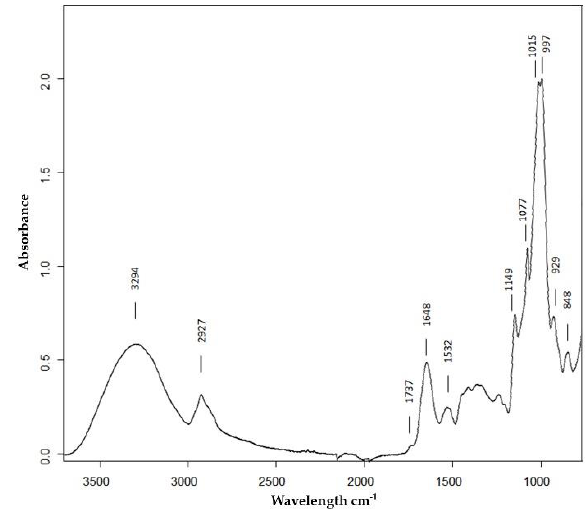
Figure 2. Average attenuated total reflection Fourier transform infrared (ATR-FTIR) spectrum between 3700 and 780 cm − 1 of the Roxo variety of milled grains in control conditions with the assignment of relevant bands.